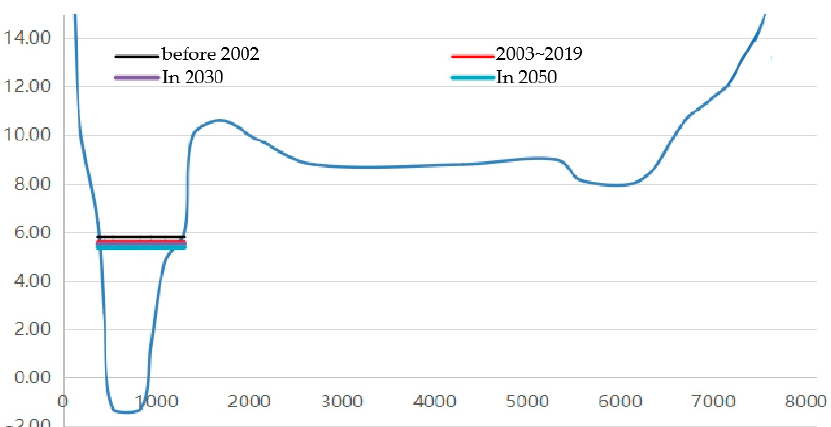
Figure 17. Analysis of the navigable depth (WL with 98% guaranteed rate) at the Xingzi